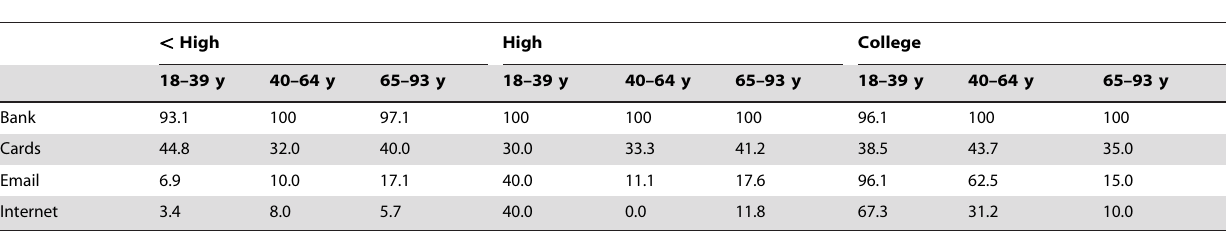
Table 3. Percentage of participants using each type of password according to age and education.